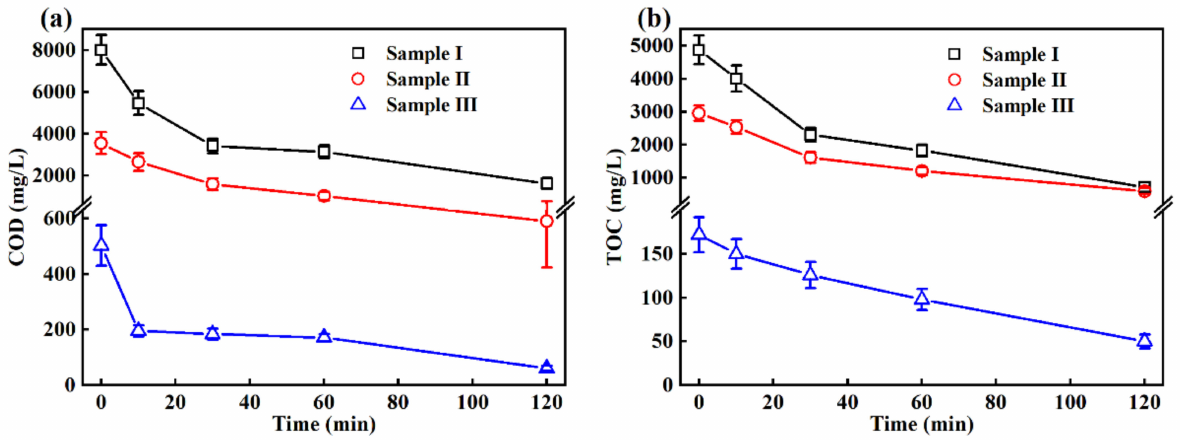
Figure 4. Changes in ( a ) COD and ( b ) TOC of wastewater in EO treatment at 50 mA/cm 2 current